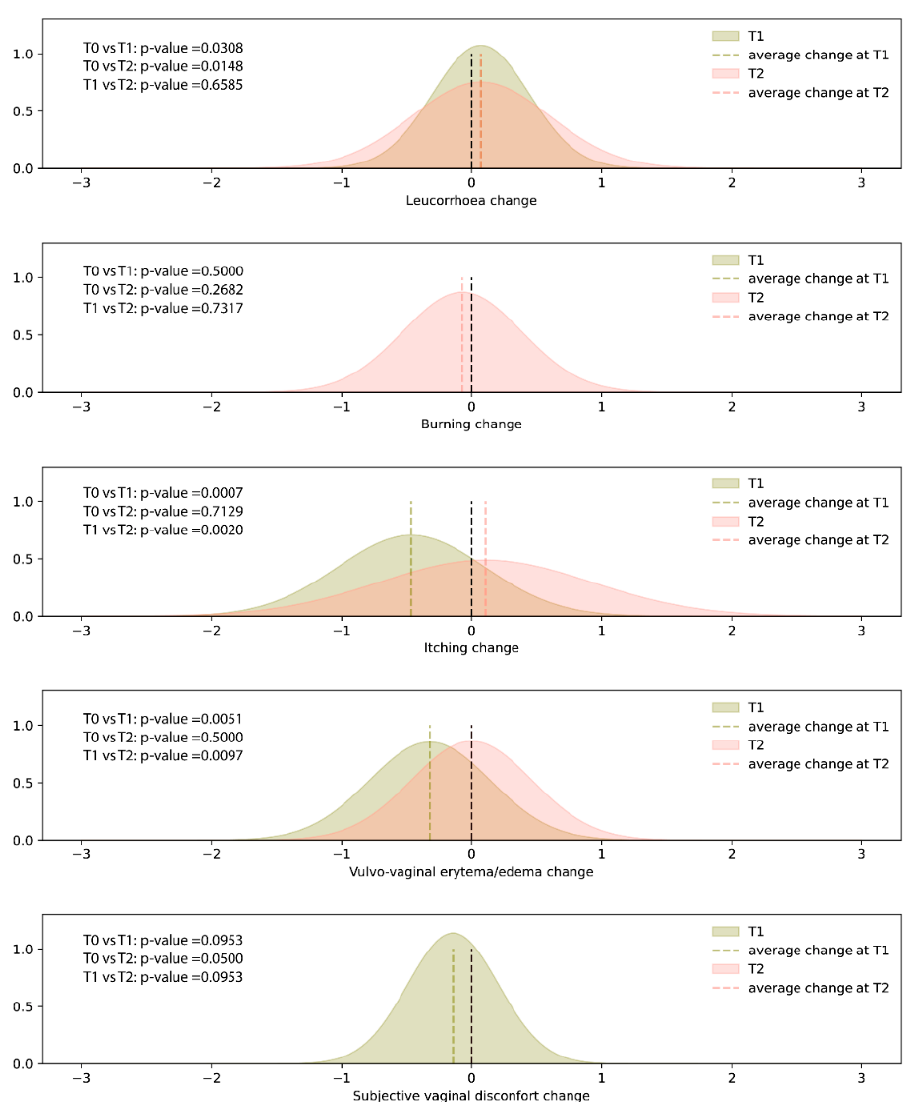
Figure 1. Density plots of the differences in the self-reported signs or symptoms (i.e., leucorrhoea, burning, itching, and subjective vaginal discomfort) scores recorded at T1 (15 days after the start of treatment and T2 (7 days after the end of treatment) sampling times, when compared with T0 (baseline). Dashed lines represent average changes.